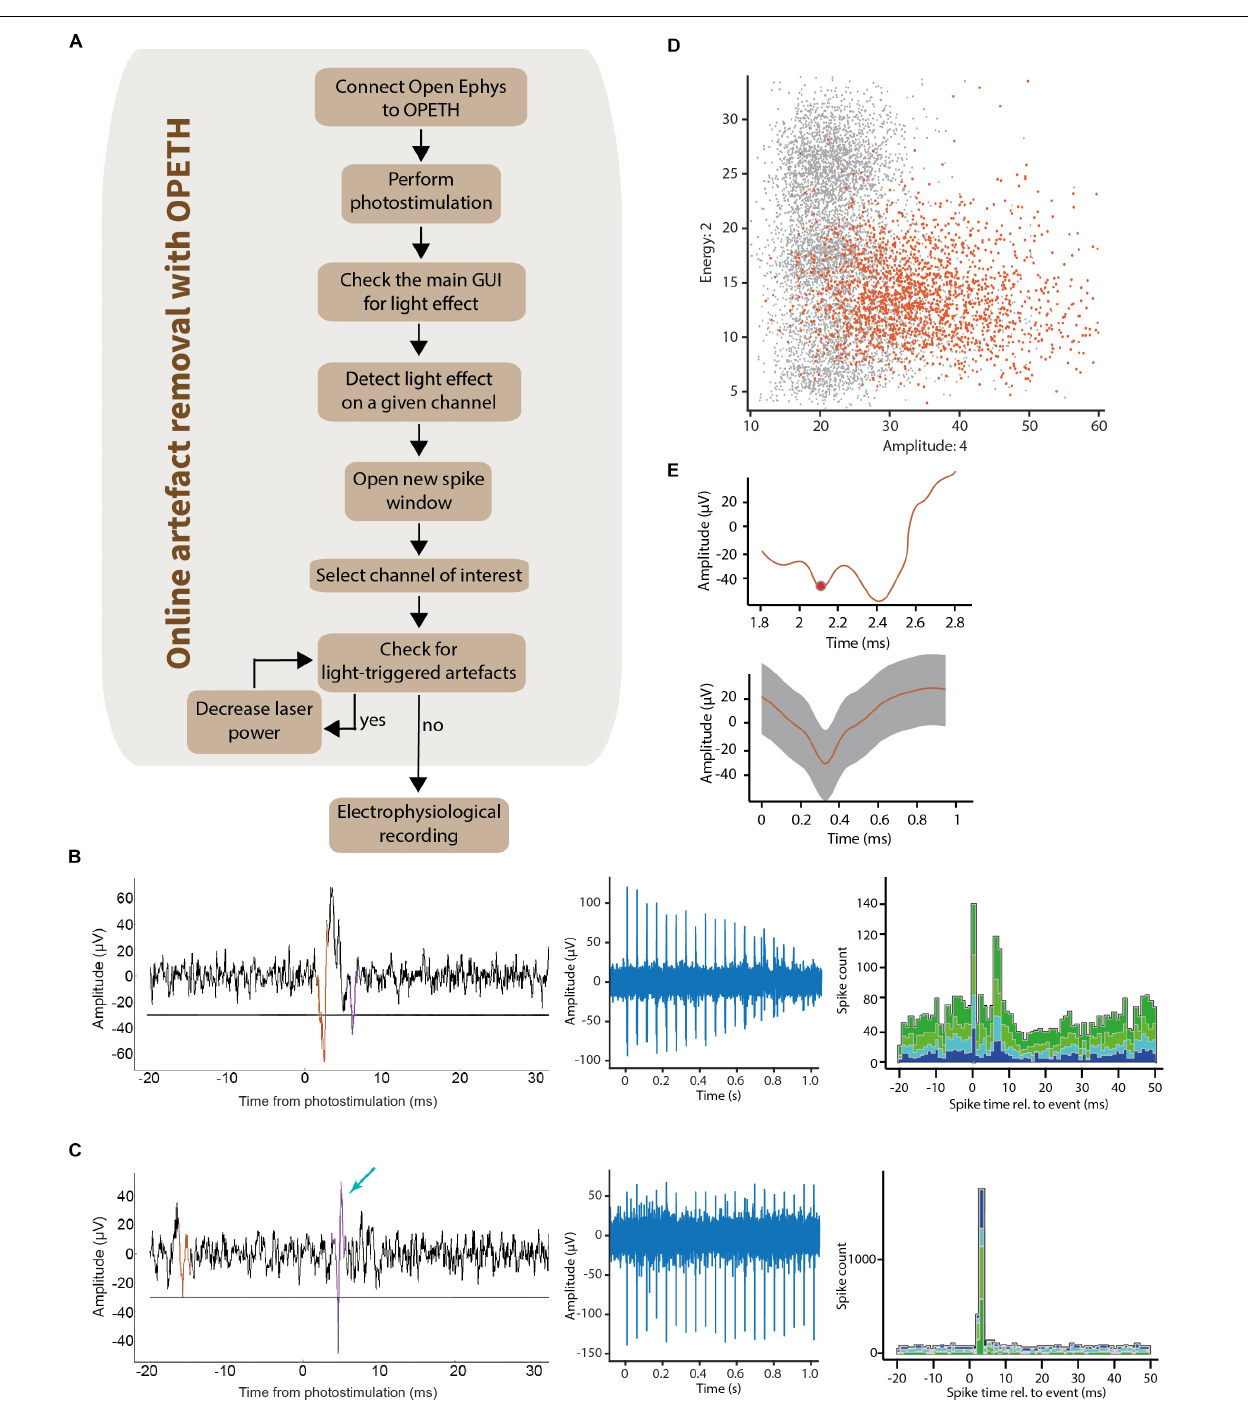
FIGURE 7 | Removing light-triggered artifacts from electrophysiological recordings. (A) It was possible to determine the channels affected by photostimulation by checking the main GUI during optogenetic tagging sessions. The raw signal was visualized using the “Open new spike window” button of the GUI. This allowed the experimenter to control laser intensity until light-triggered artifacts disappeared from the plots. (B) Left, raw data of the light-evoked artifact aligned to photostimulation (waveform superimposed in color). Middle, decreasing the laser intensity lead to decreasing amplitude of the artifacts. Right, the corresponding OPETH histogram showed a bimodal PETH caused by the “W shape” of the light-evoked artifacts. (C) Left, raw data of a light-evoked spike (waveform superimposed in color, indicated by blue arrow). Middle, the all-or-none spikes did not show amplitude changes upon decreasing stimulation intensities. Right, corresponding online histogram in the main OPETH window. (D) Waveforms plot in feature space showed a high dispersion of the light-evoked artifacts (orange). (E) Top, raw signal of the light-evoked artifact in the OPETH Spike window . Bottom, average artifact waveform in the offline analysis.